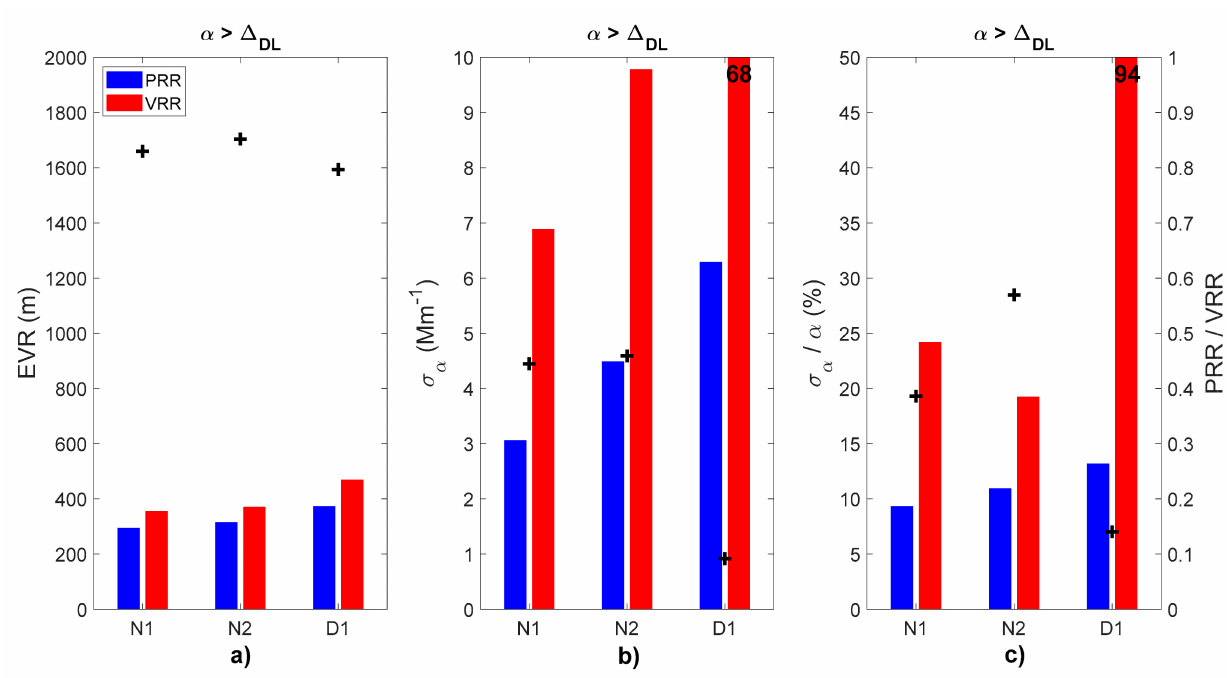
Figure 10. Comparative histograms of layer-mean values of the ( a ) vertical resolution, ( b ) absolute uncertainty and ( c ) relative uncertainty in the main surface aerosol layer ( α aer > ∆ DL ) retrieved by the SCC from PRR and VRR signals for cases N1, N2 and D1. Black plus signs (right axis) are the ratio PRR to VRR. For layer-mean values exceeding the selected vertical scale the numerical value is reported in black on the top of the